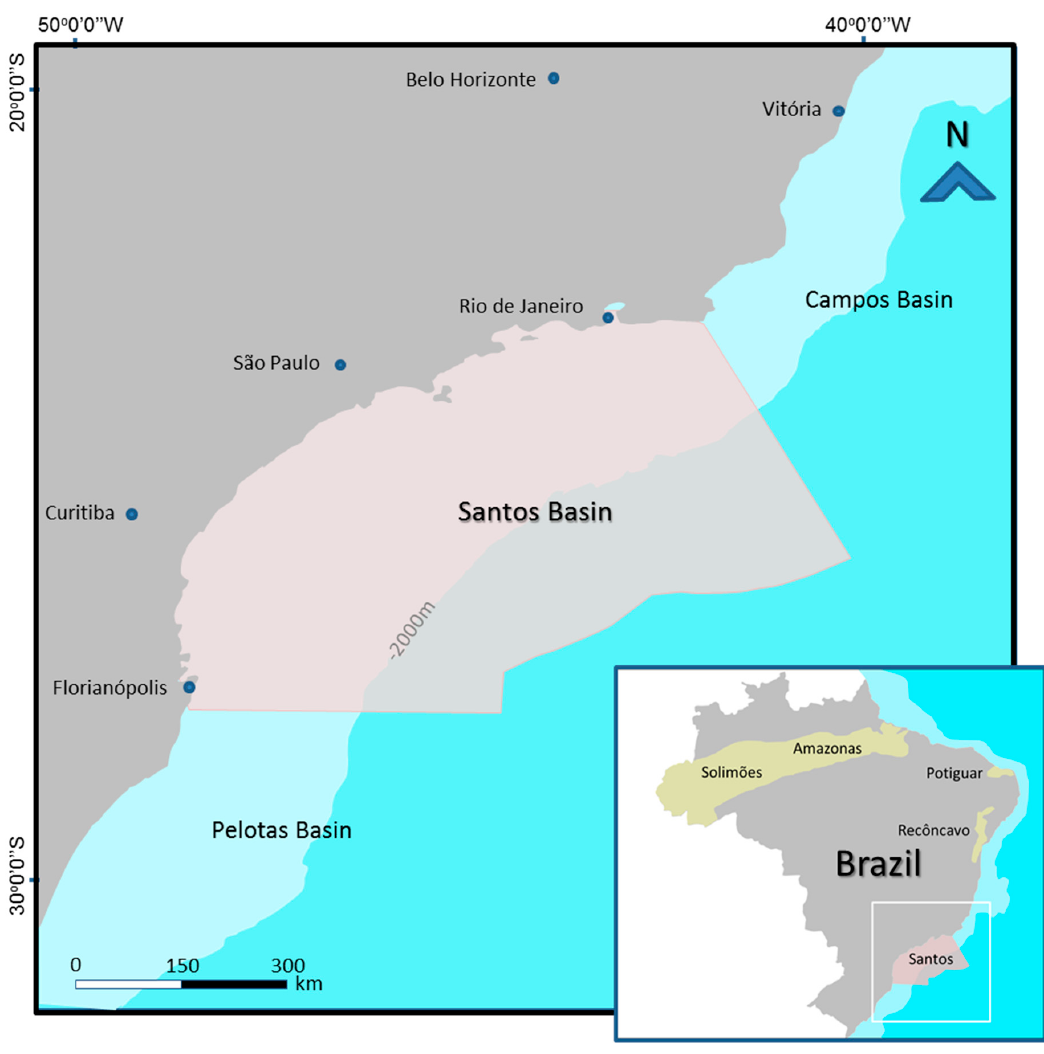
Figure 1. Santos Basin Location.